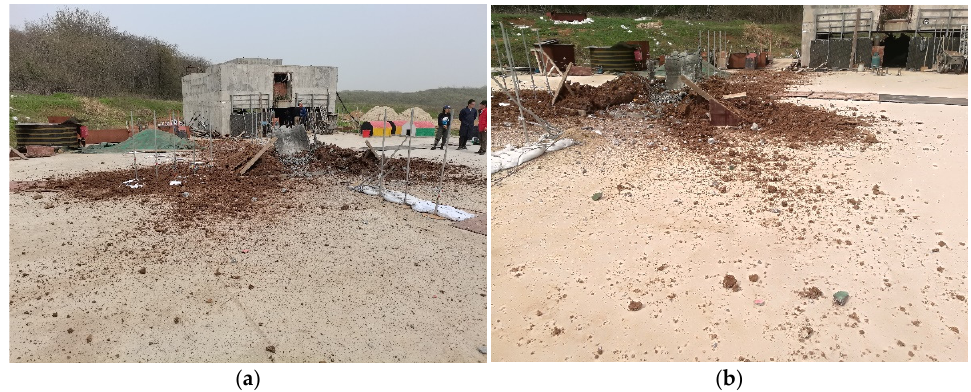
Figure 9. Model failure. ( a ) Left view; ( b ) right view.